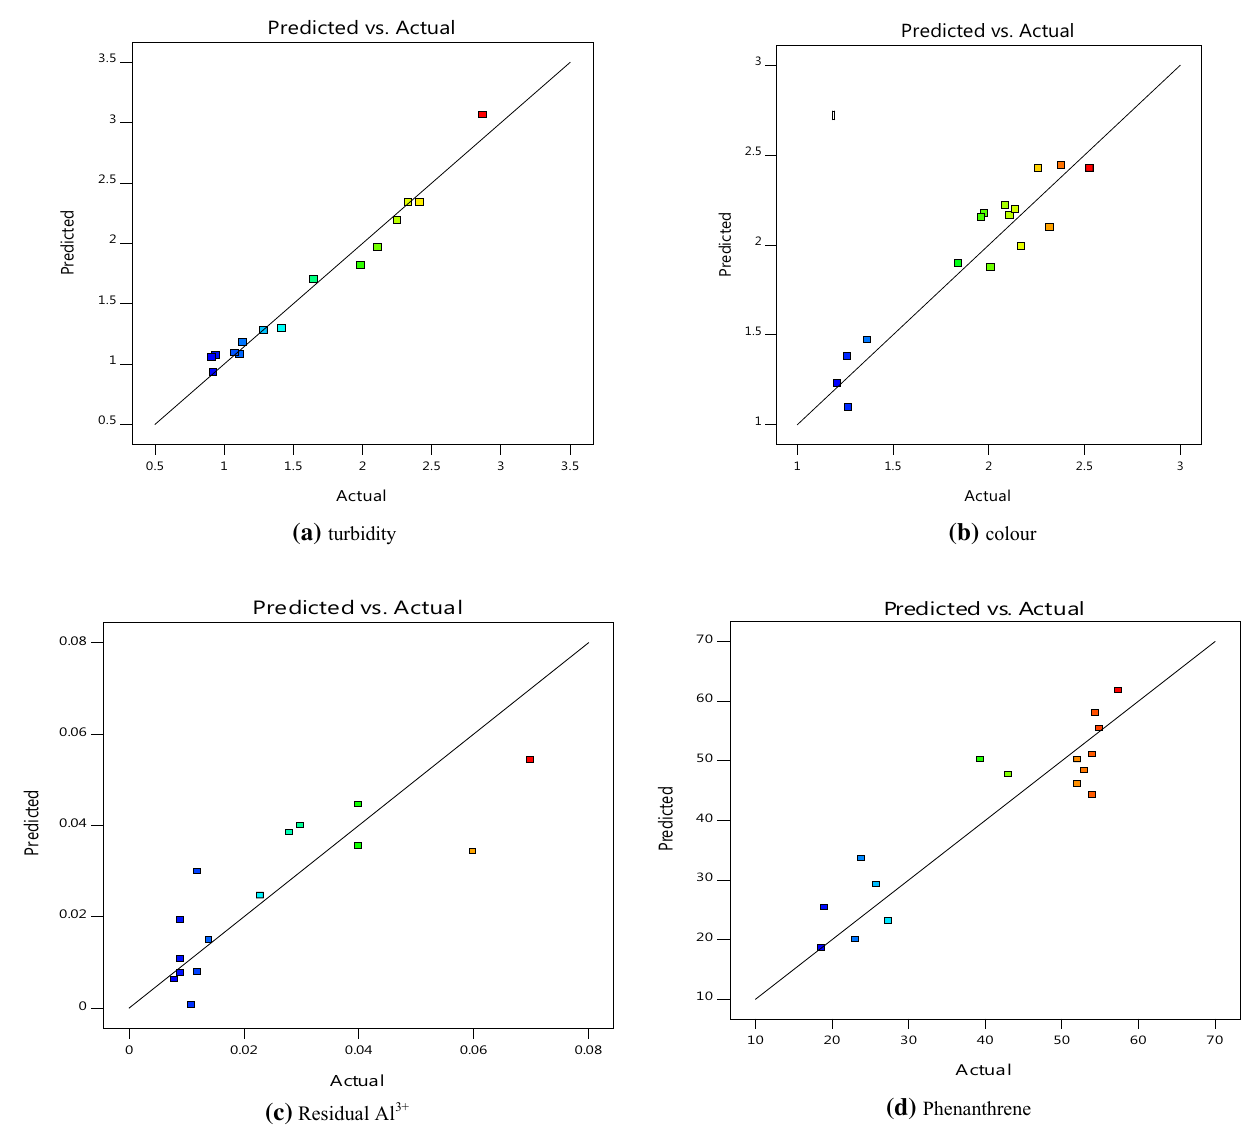
Fig. 2 Testing the validity of the model for the response